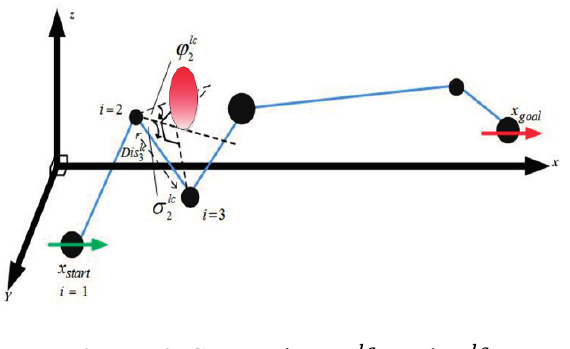
Figure 4. Computing (cid:2030) (cid:2870)(cid:3039)(cid:3030) and (cid:2026) (cid:2870)(cid:3039)(cid:3030) .